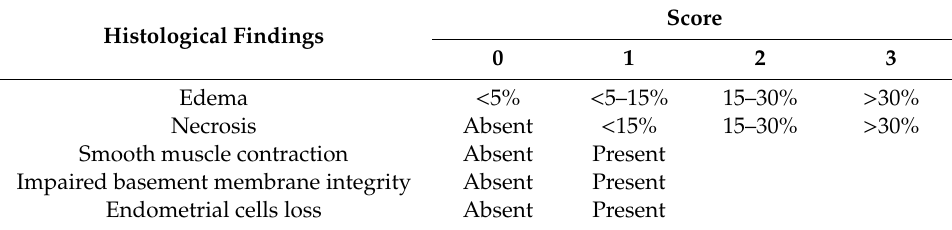
Table 2. The scoring system for uterus static cold storage (SCS) damage